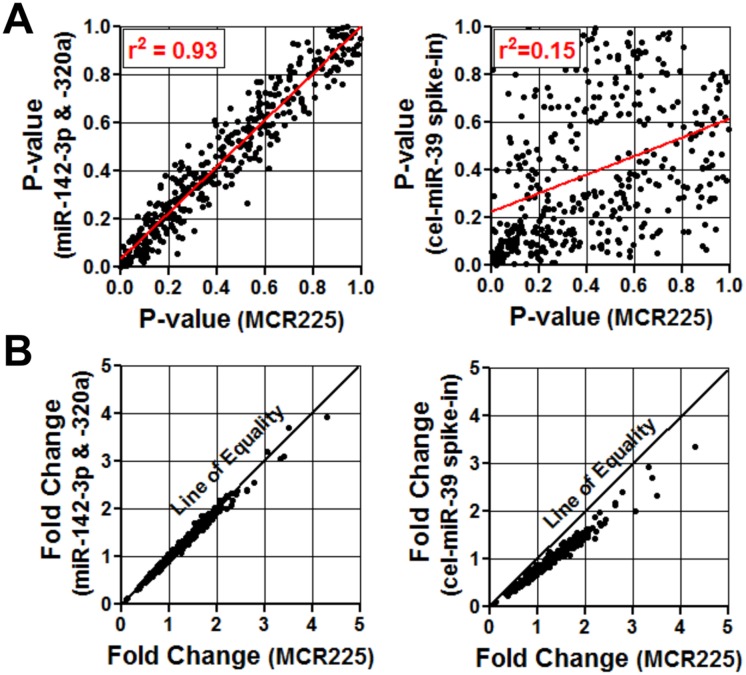
Comparison of internal and external reference controls versus the benchmark MCR normalization method.
A. Scatter plots showing distribution of p-values for the differences in plasma levels of each miRNA (dot) analyzed in the PAH screening cohort (n = 3 IPAH vs. n = 4 healthy control subjects), after normalization with different reference controls. Left panel compares results after normalization by the internal reference pair miR-142-3p and miR-320a, versus the geomean of all 225 miRNAs comprising the initial candidate reference pool (MCR225). Right panel compares results after normalization by the external cel-miR-39 spike-in versus MCR225. B. Scatter plots showing the fold-change in plasma level of each miRNA (dot) between IPAH and control groups, after normalization with different reference controls. Left panel compares results of miR-142-3p/miR-320a pair versus MCR. Right panel compares results of cel-miR-39 spike-in versus MCR225.